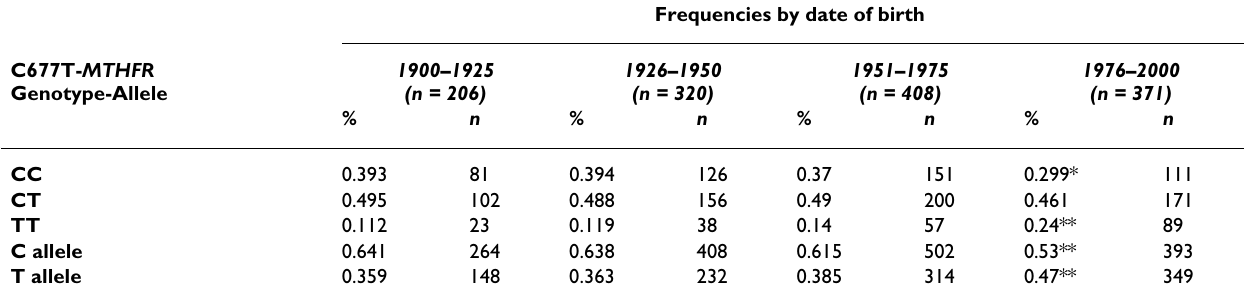
Frequencies by date of birth